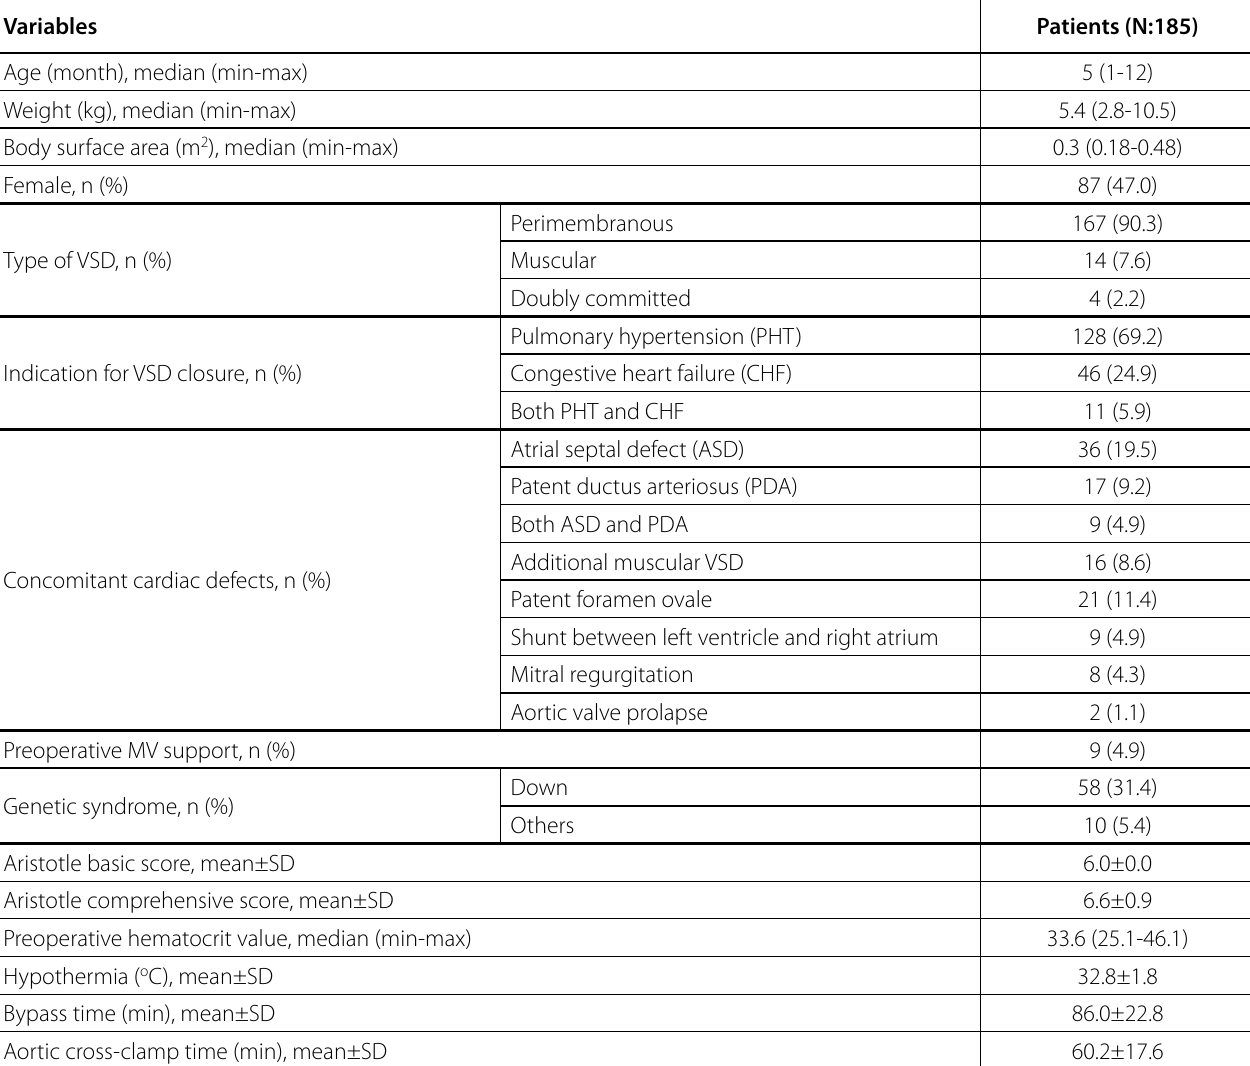
Table 1 . Patients’ baseline characteristics and operative